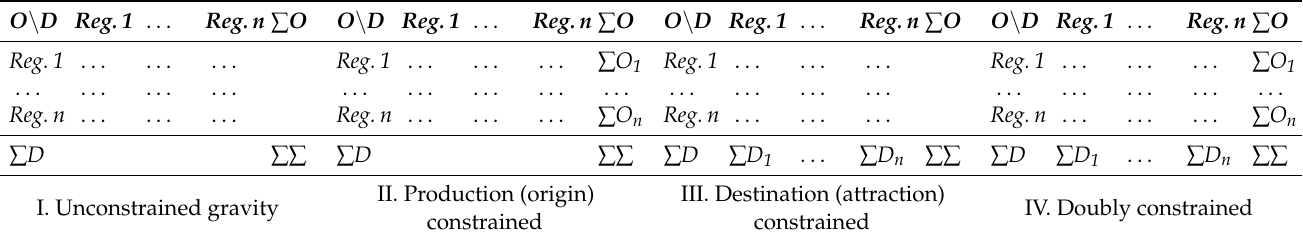
Table 1. Spatial interaction models